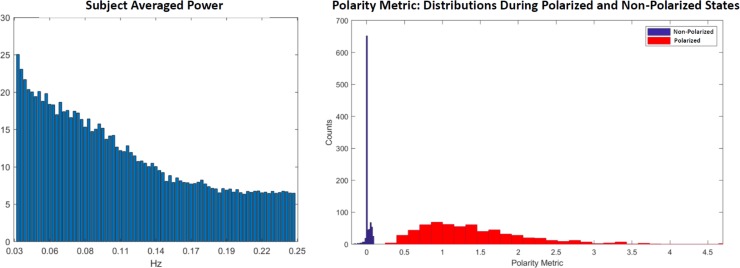
Using scalar valued measure Π(t) of time-varying whole-brain polarization we see that (Left) the oscillatory pattern in degree of polarity has power decaying in frequency and no discernible peaks that would point to biological rhythms associated with respiration or heartbeat; (Right) The value of Π(t) clearly separates for timepoints at which the whole brain is in the Non-Polarized dPR state (blue) vs. timepoints at which the whole brain is one of the two polarized (Polarized-High, Polarized-Low) states (red).